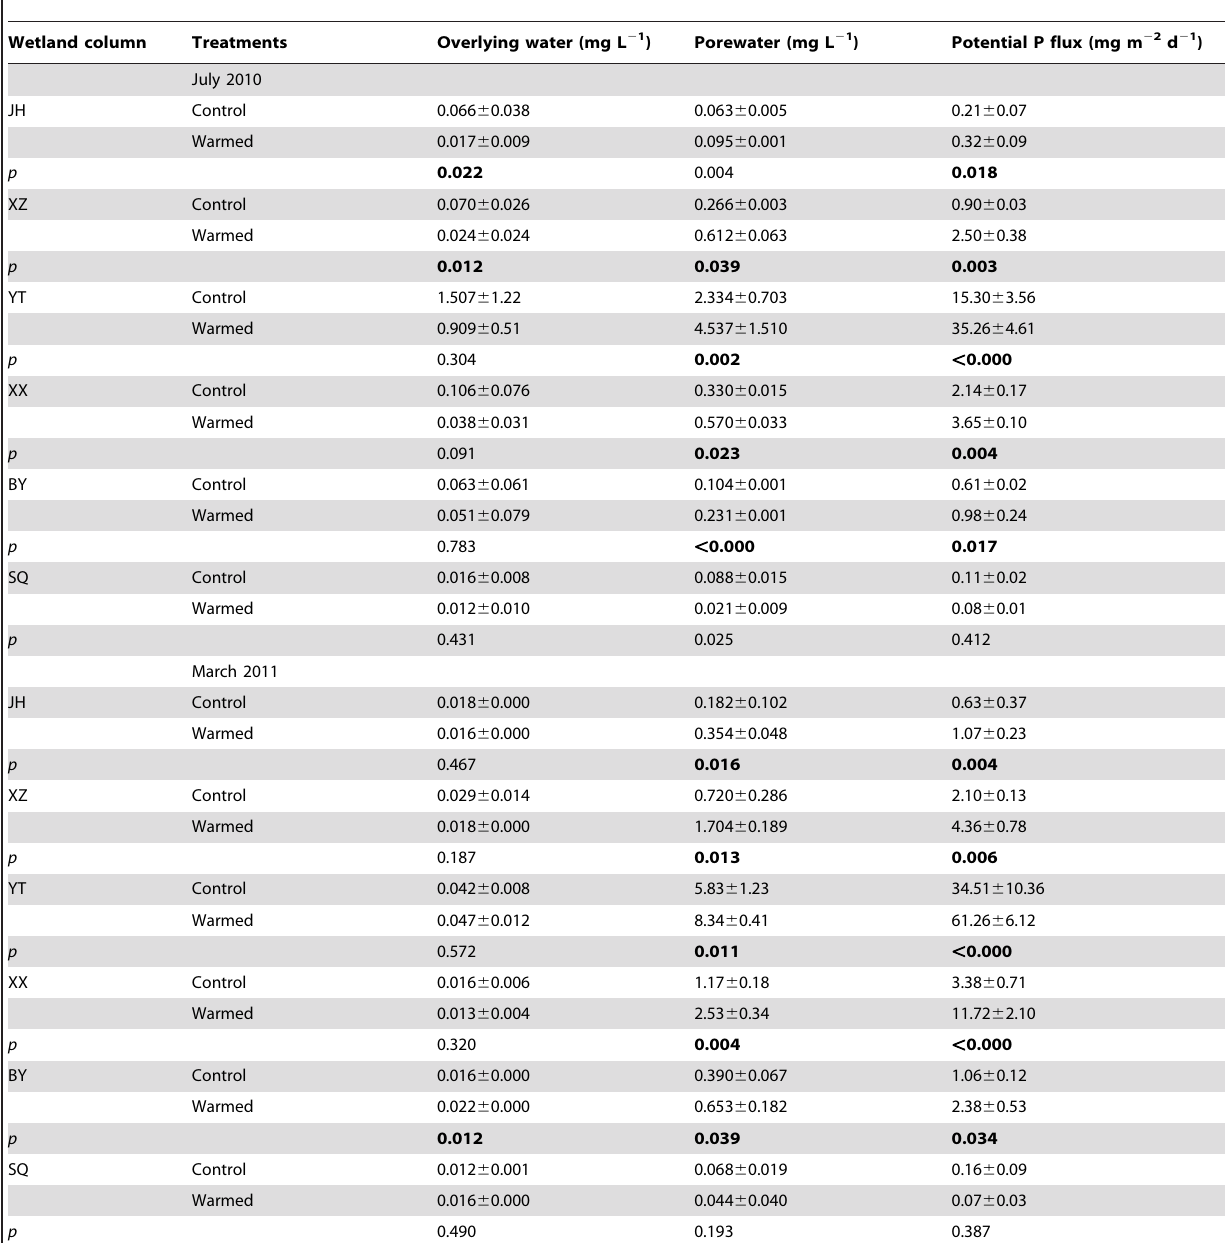
Table 2. Phosphorus (P) concentrations in overlying water and porewater, and the potential flux of dissolved reactive P in wetland columns in the microcosm experiment (Control: ambient temperature; Warmed: ambient temperature + 5 u C).